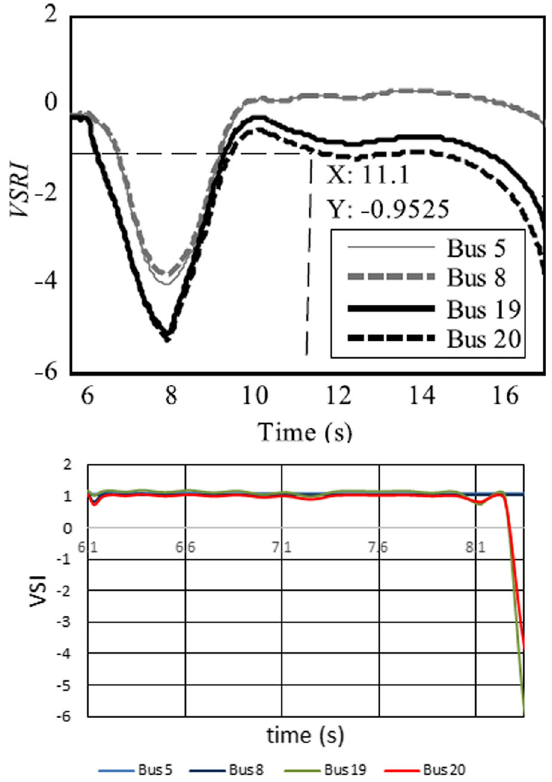
Fig. 19 VSRI and VSI post contingency